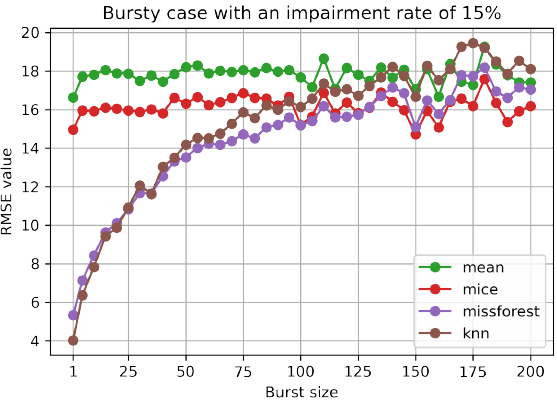
Figure 5. RMSE value for bursty case with 15% impairment